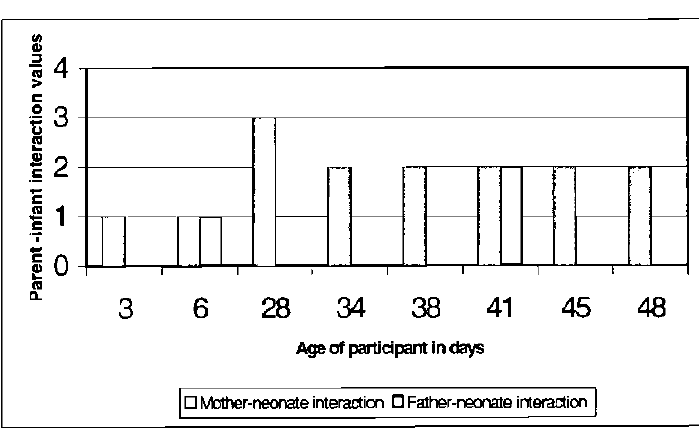
Figure 3. Parent-infant interaction during the participant's stay in the NICU. Note: Parent-infant interaction values: 1= never; 2= sometimes; 3= often; 4=